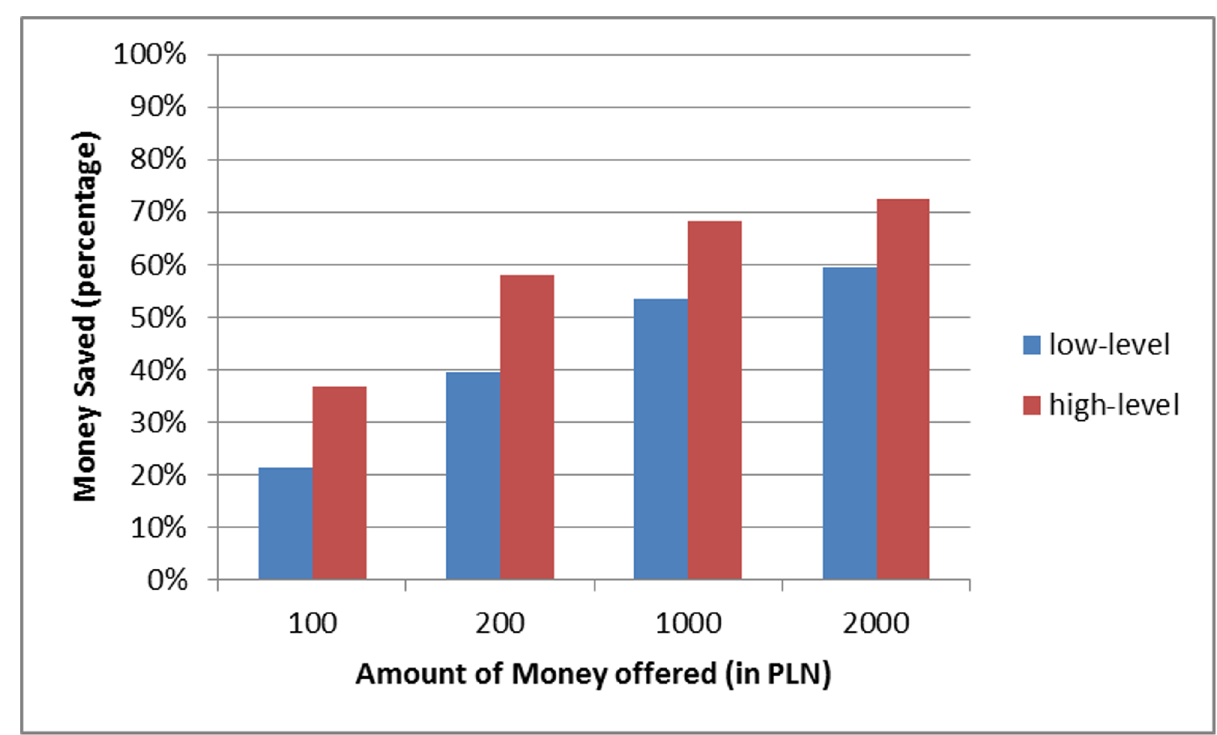
Fig 3. Percentages of offered sums ascribed to saving in high- and low-level construal conditions.